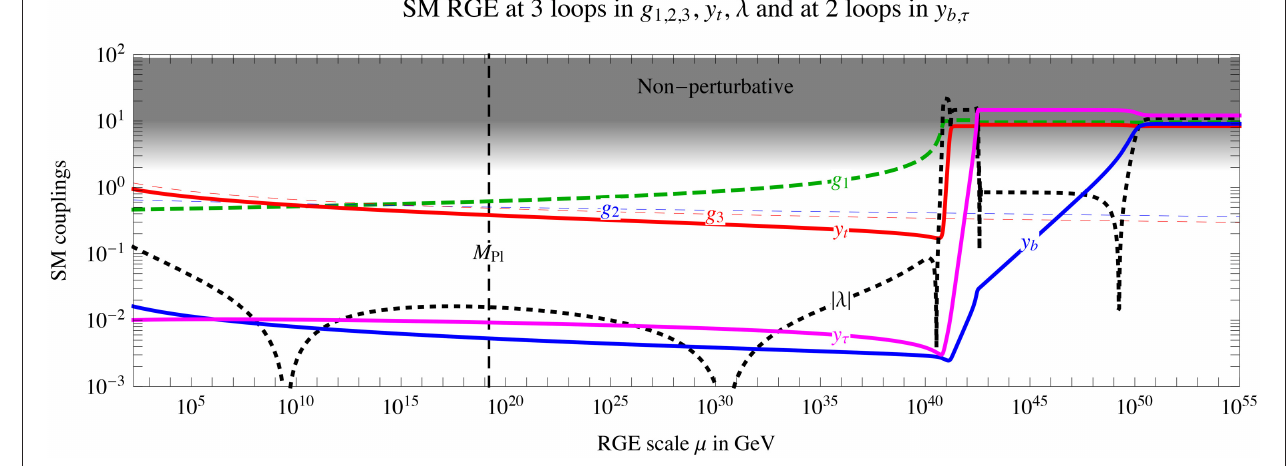
FIGURE 1 | Illustration of a possible RGE running in the SM. We assumed central values for all parameters, and solved the 3 loop RGE equations. In order to obtain an asymptotically safe behavior we artificially removed the bottom and tau Yukawa contributions to the 3-loop term in the RGE. This only affects the running in the non-perturbative region above 10 40 GeV , where the result cannot of course be trusted. Furthermore, we ignored the Yukawa couplings of the lighter generations, and gravity.